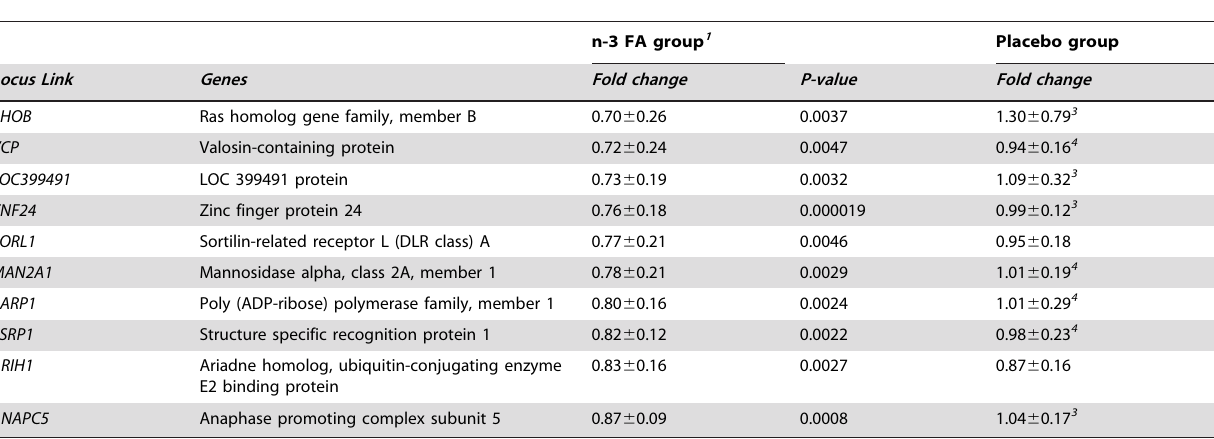
Table 2. Genes down-regulated by a DHA rich n-3 fatty acid or placebo